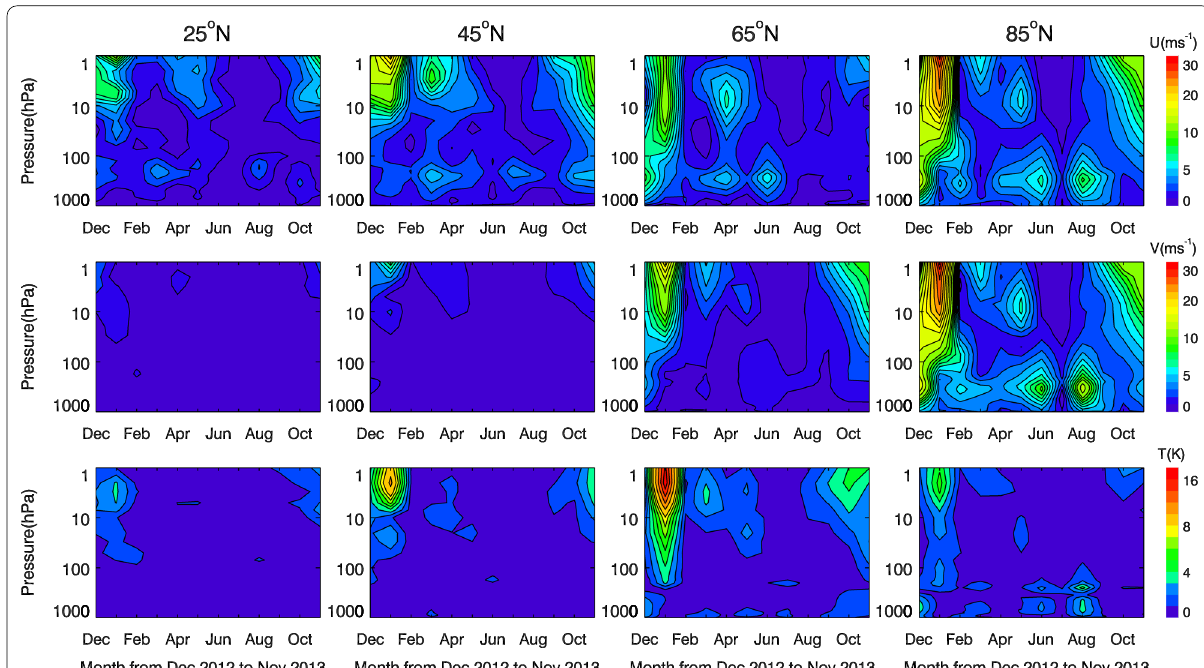
Fig. 4 Altitude versus month-of-year structures of the W1 Q16DW amplitudes for the zonal wind (top), meridional wind (middle) and temperature (bottom) at 25 ◦ N (first column), 45 ◦ N (second column), 65 ◦ N (third column) and 85 ◦ N (last column)